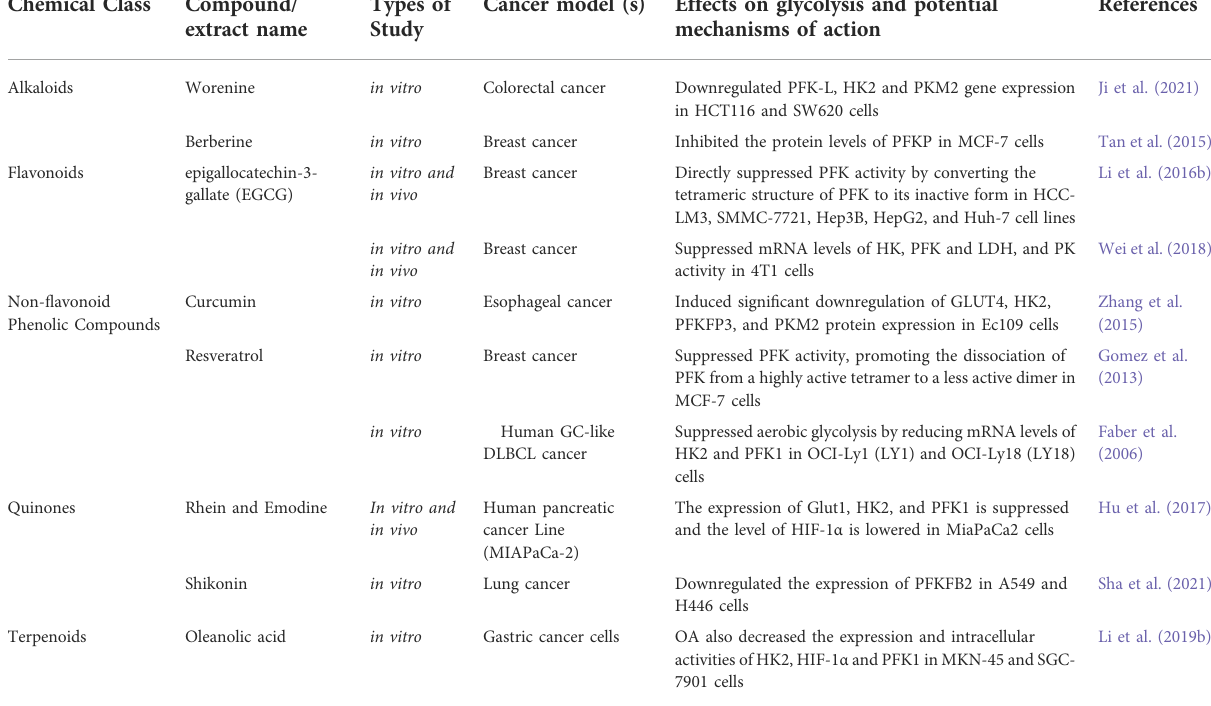
TABLE 2 Natural compounds target phosphofructokinase 1